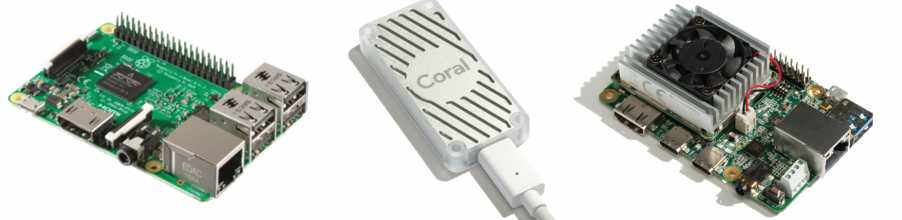
Figure 2. General-purpose embedded platforms and TPU-based platforms: RPi 4B ( left ), USB Coral TPU ( center ) and Coral Devboard ( right ).